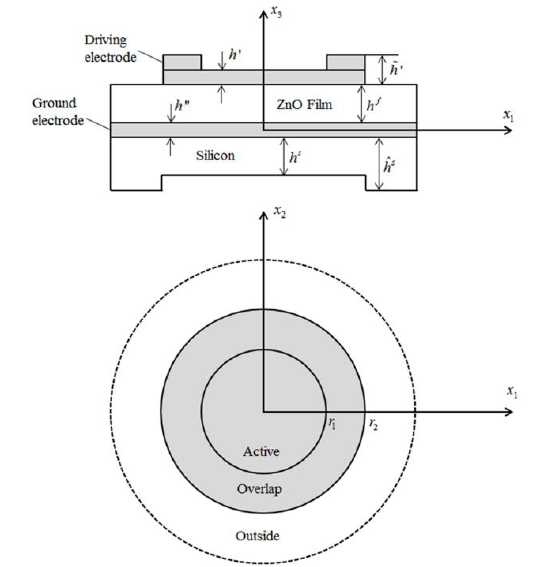
Figure 1. The schematic of a ZnO film bulk acoustic resonator (FBAR) with a circular frame-like driving electrode. It consists of a driving electrode, a ZnO film, a ground electrode, and a Si substrate, where h indicates the thickness of each region and r represents the electrode size.